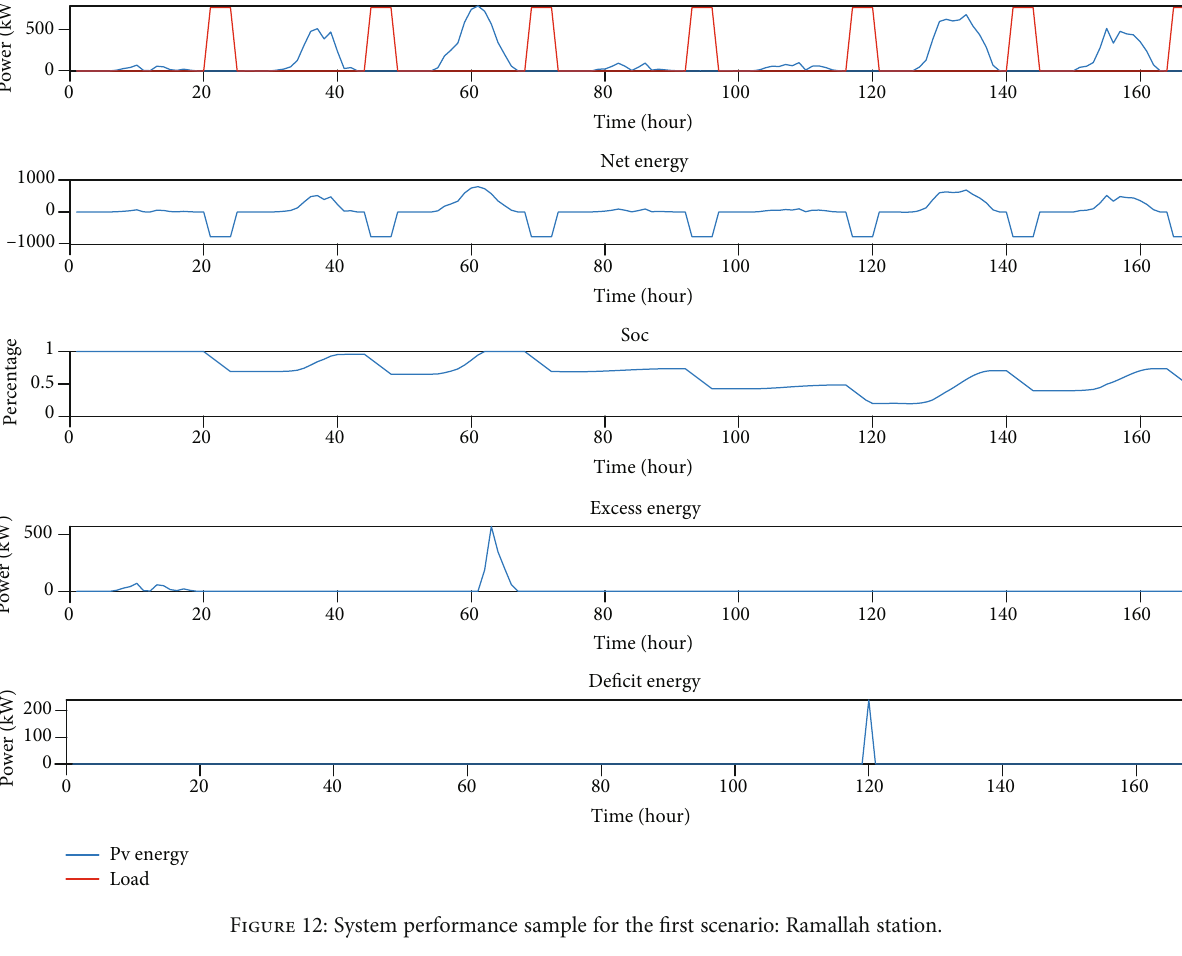
Figure 12: System performance sample for the fi rst scenario: Ramallah station.